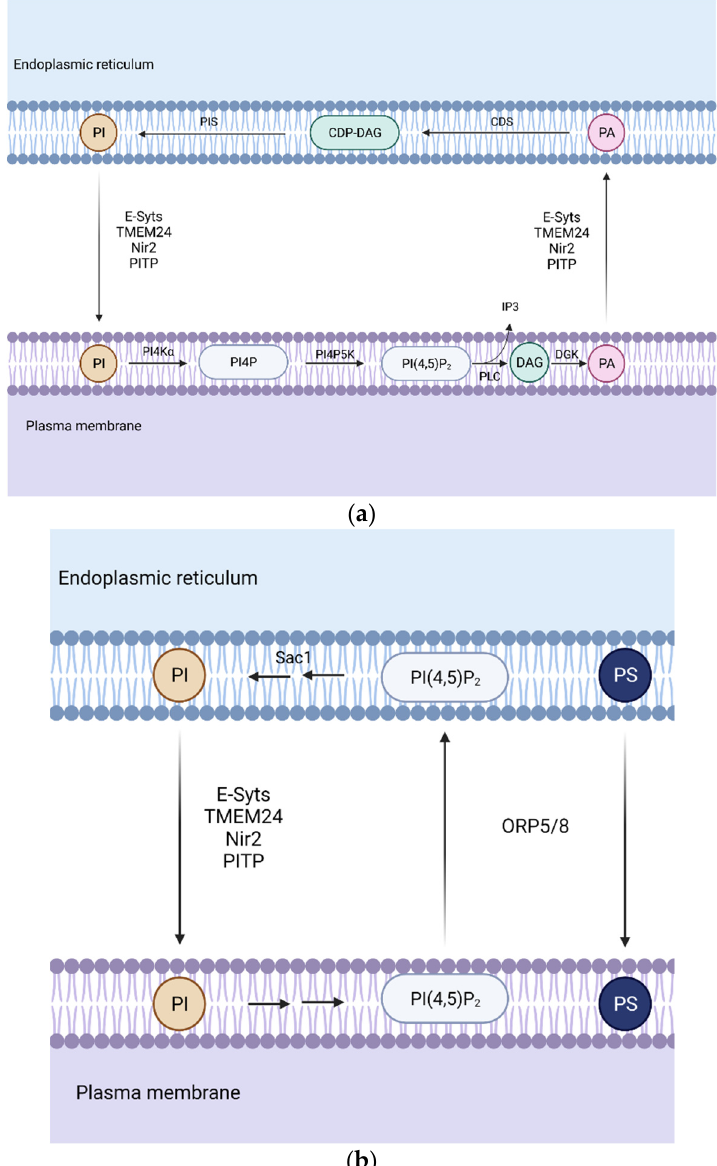
Figure 2. Representation of the phospholipid transport during phospholipase C (PLC) signaling. ( a ) Association between the endoplasmic reticulum (ER) and the plasma membrane (PM) is required in order to ensure high levels of phosphatidylinositol 4,5-biphosphate PI(4,5)P 2 which can drop quickly during PLC signaling. ( b ) Phosphatidylserine (PS) transport and PI(4,5)P 2 and phosphatidyli- nositol 4-phosphate PI4P removal. Oxysterol-binding protein (OSBP)-related protein 5/8 (ORP5/8) removes PI(4,5)P 2 and PI4P from the PM and transfers PS from the ER to PM in exchange, creating a gradient necessary for phosphatidylinositol (PI) transport. Abbreviations: PI4K α , phosphatidyli- nositol 4-kinase; PI4P5K, phosphatidylinositol 4-phosphate 5-kinase; DGK, diacylglycerol kinase; PIS, phosphatidylinositol synthase; CDS, CDP-diacylglycerol synthase; synaptotagmins (E-Syts); the Phospholipid Transfer Protein C2CD2L (also known as TEM24 or C2CD2L); membrane-associated phosphatidylinositol transfer protein 1 (Nir2); phosphatidylinositol transfer protein (PITP). Another class of LTPs are the extended synaptotagmins (E-Syts). They are localized as integral membrane proteins in the ER. Their structure contains several antiparallel β - sandwich that contains three Ca 2+ -binding loops (C2 domains) and an SMP (synaptotagmin- like mitochondrial lipid-binding) domain, which has no selectivity for any